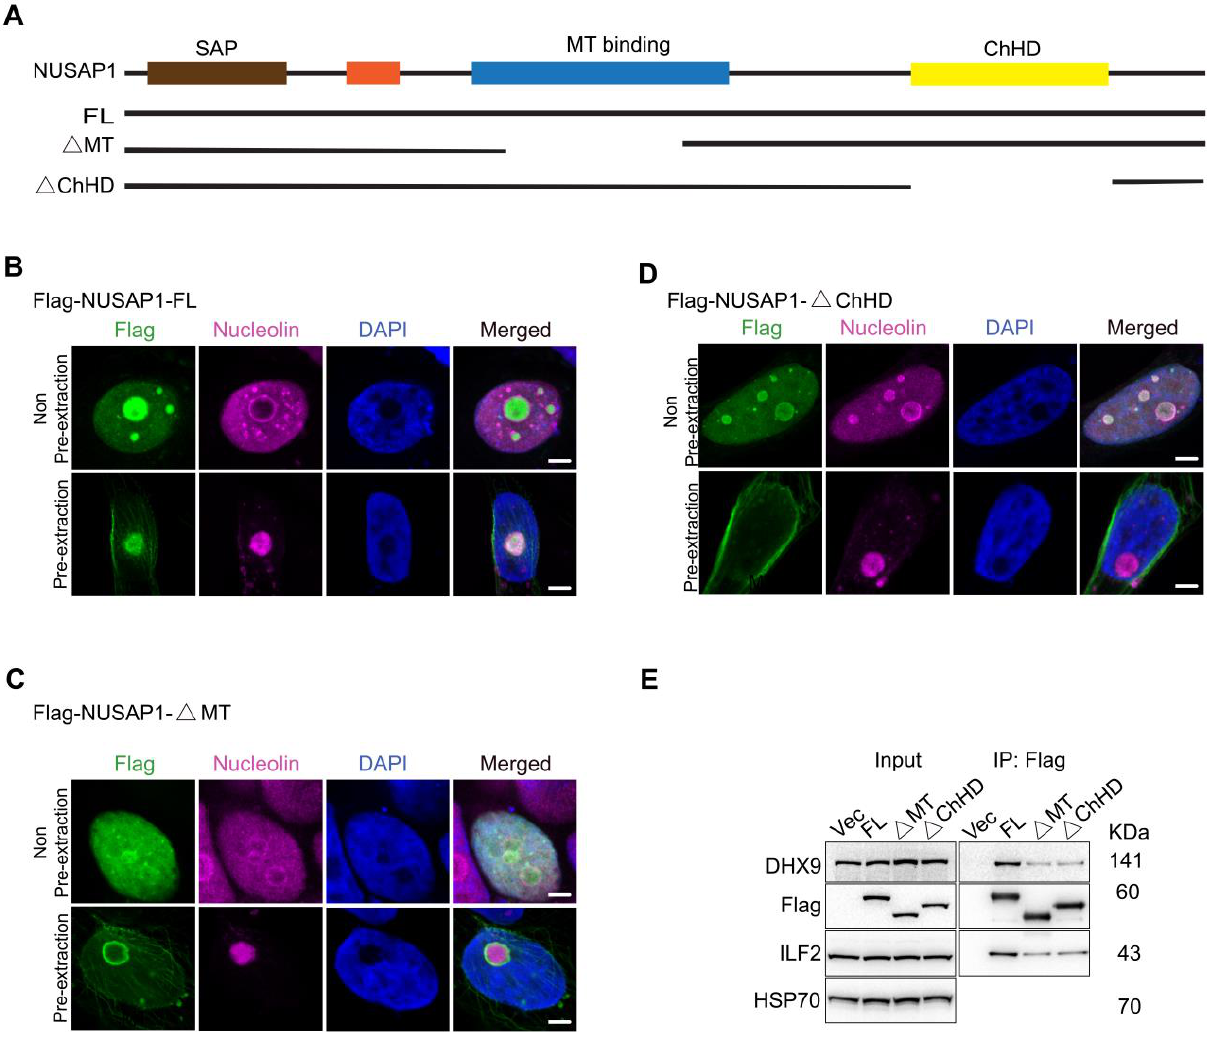
Figure 2. NUSAP1 interactions with DHX9 and ILF2 require MT and ChHD domains. ( A ) Summary of the full-length Flag-NUSAP1 (FL), MT domain (fragment 243–367) deletion Flag-NUSAP1 (ΔMT) and ChHD deletion Flag-tagged NUSAP1 (ΔChHD) fragment plasmids. ( B – D ) Representative con- focal microscopy images of localization of Flag-NUSAP1-FL ( B ), -ΔMT ( C ), and -ΔChHD ( D ). Scale bar = 10 µm. ( E ) IP-WB shows decreased binding of Flag-NUSAP1-ΔMT and ΔChHD mutants to DHX9 and ILF2 compared to Flag-NUSAP1-FL in LNCaP cells.